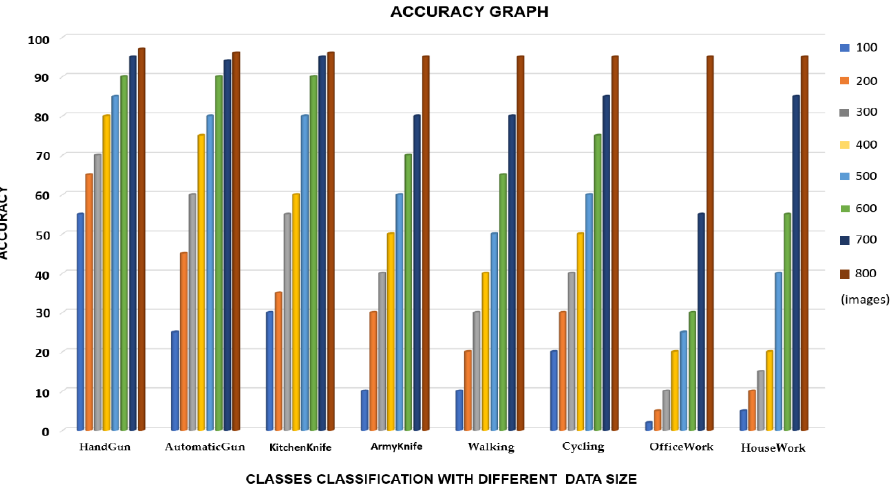
Figure 6. The accuracy of each subclass with respect to the trained batches of images. Colors representing each aspect are shown in the legend.